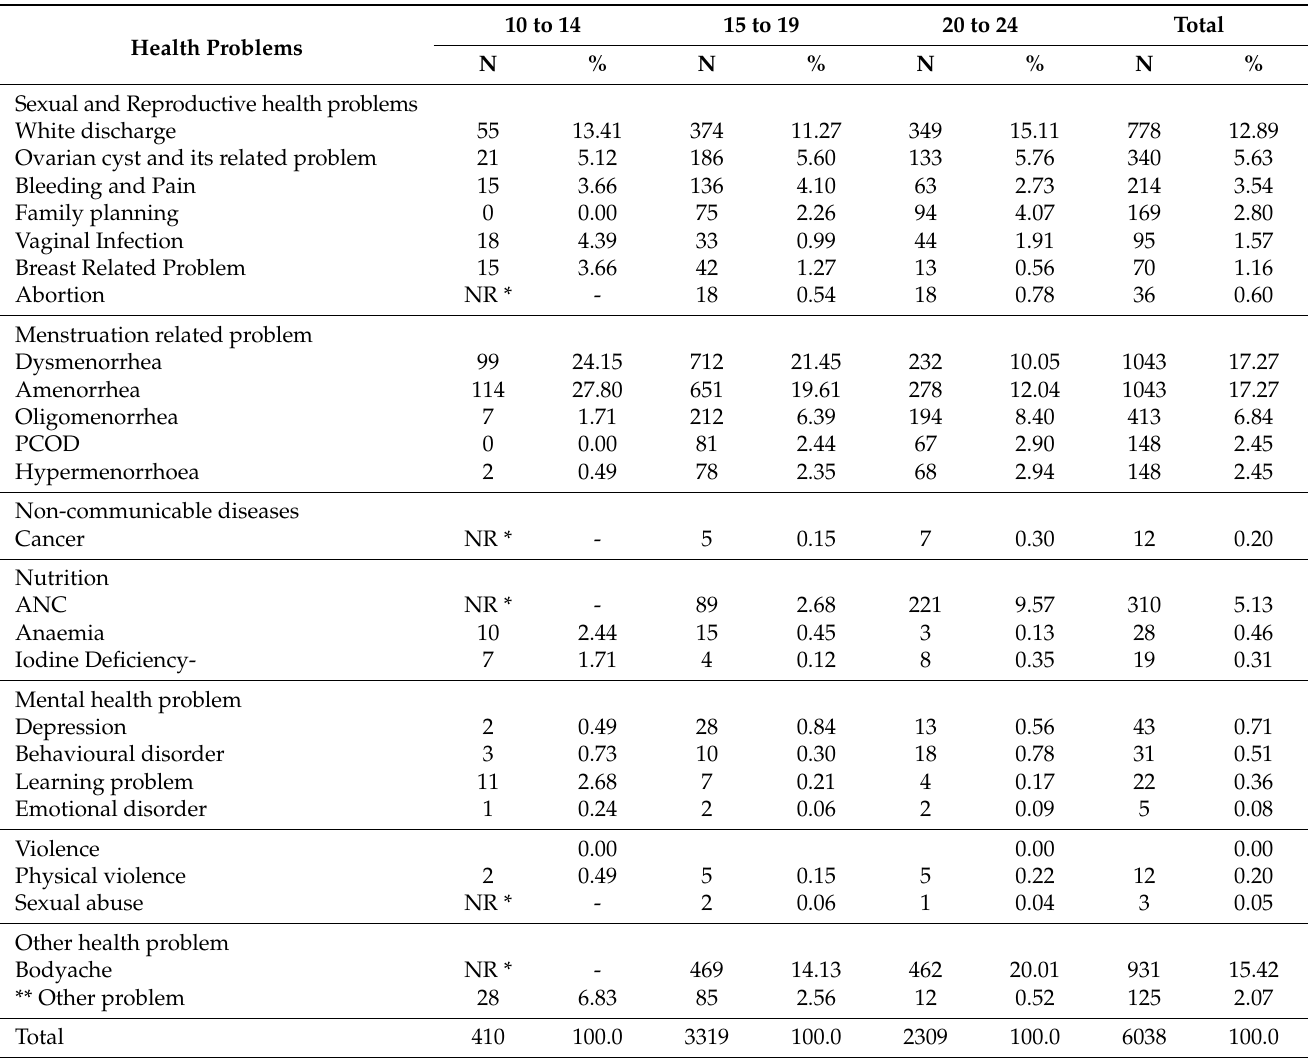
Table 5. Distribution of beneficiaries by their health problems ( n = 6038).